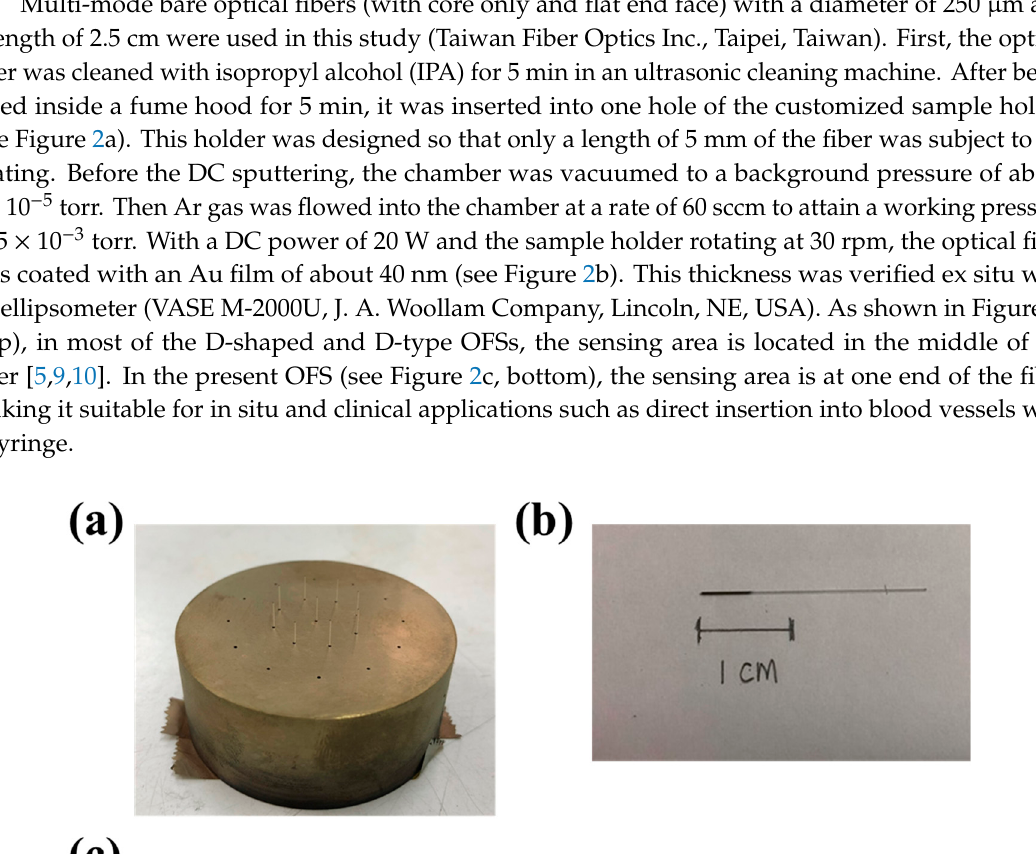
Figure 1. The present optical fiber sensor (OFS) (left) resembles the Kretschmann’s configuration (right).